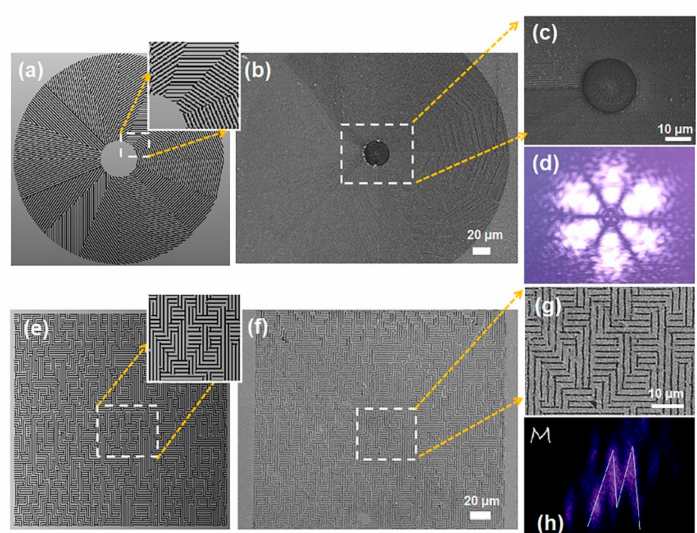
Figure 5. Femtosecond-laser direct writing (FsLDW) of dielectric gradient metasurface optical elements. The designed ( a ) and experimental ( b , c ) vortex phase Q-plate. ( d ) Intensity readout of Q-plates with linearly polarized beam; The designed ( e ) and experimental ( f , g ) geometric-phase Fourier holograms for a letter of “M”. ( h ) the Fourier hologram element of a letter “M” illuminated by a laser at a wavelength of 808